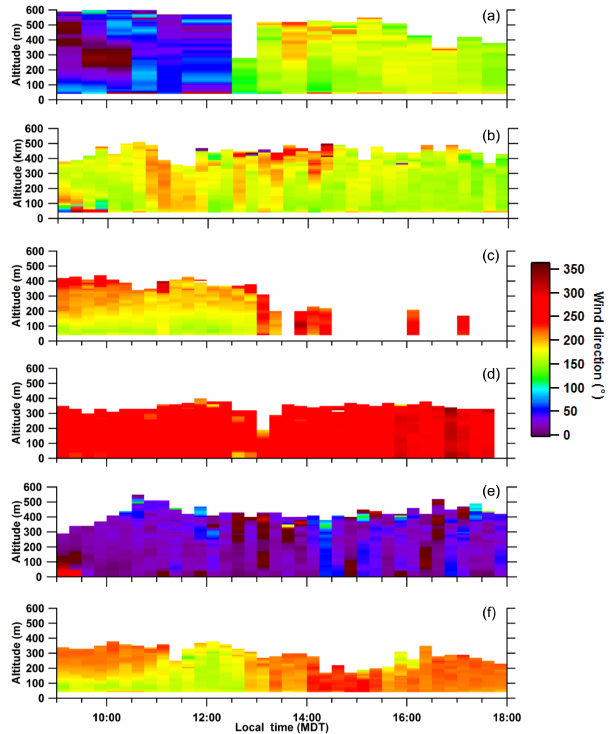
Figure 2. Vertical profiles of wind speed: 23 August (a) , 3 Septem- ber (b) , 4 September (c) , 5 September (d) , 6 September (e) , and 7 September (f) .